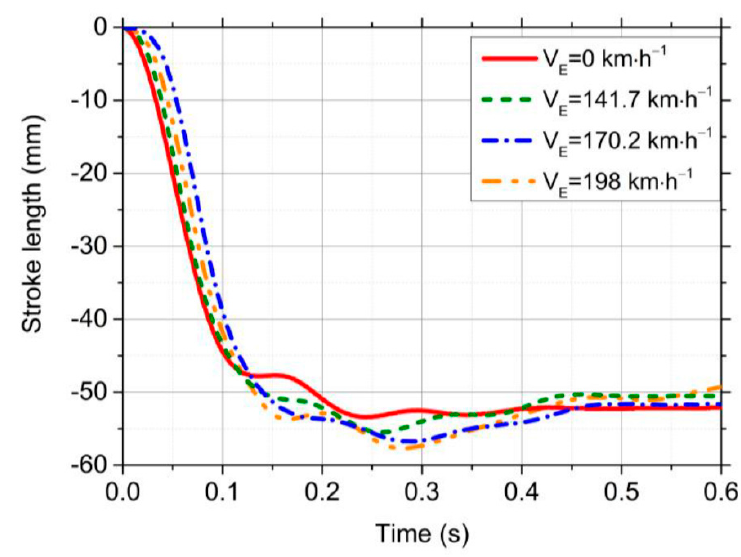
Figure 17. Changes of stroke length of arresting hook at different horizontal velocity.